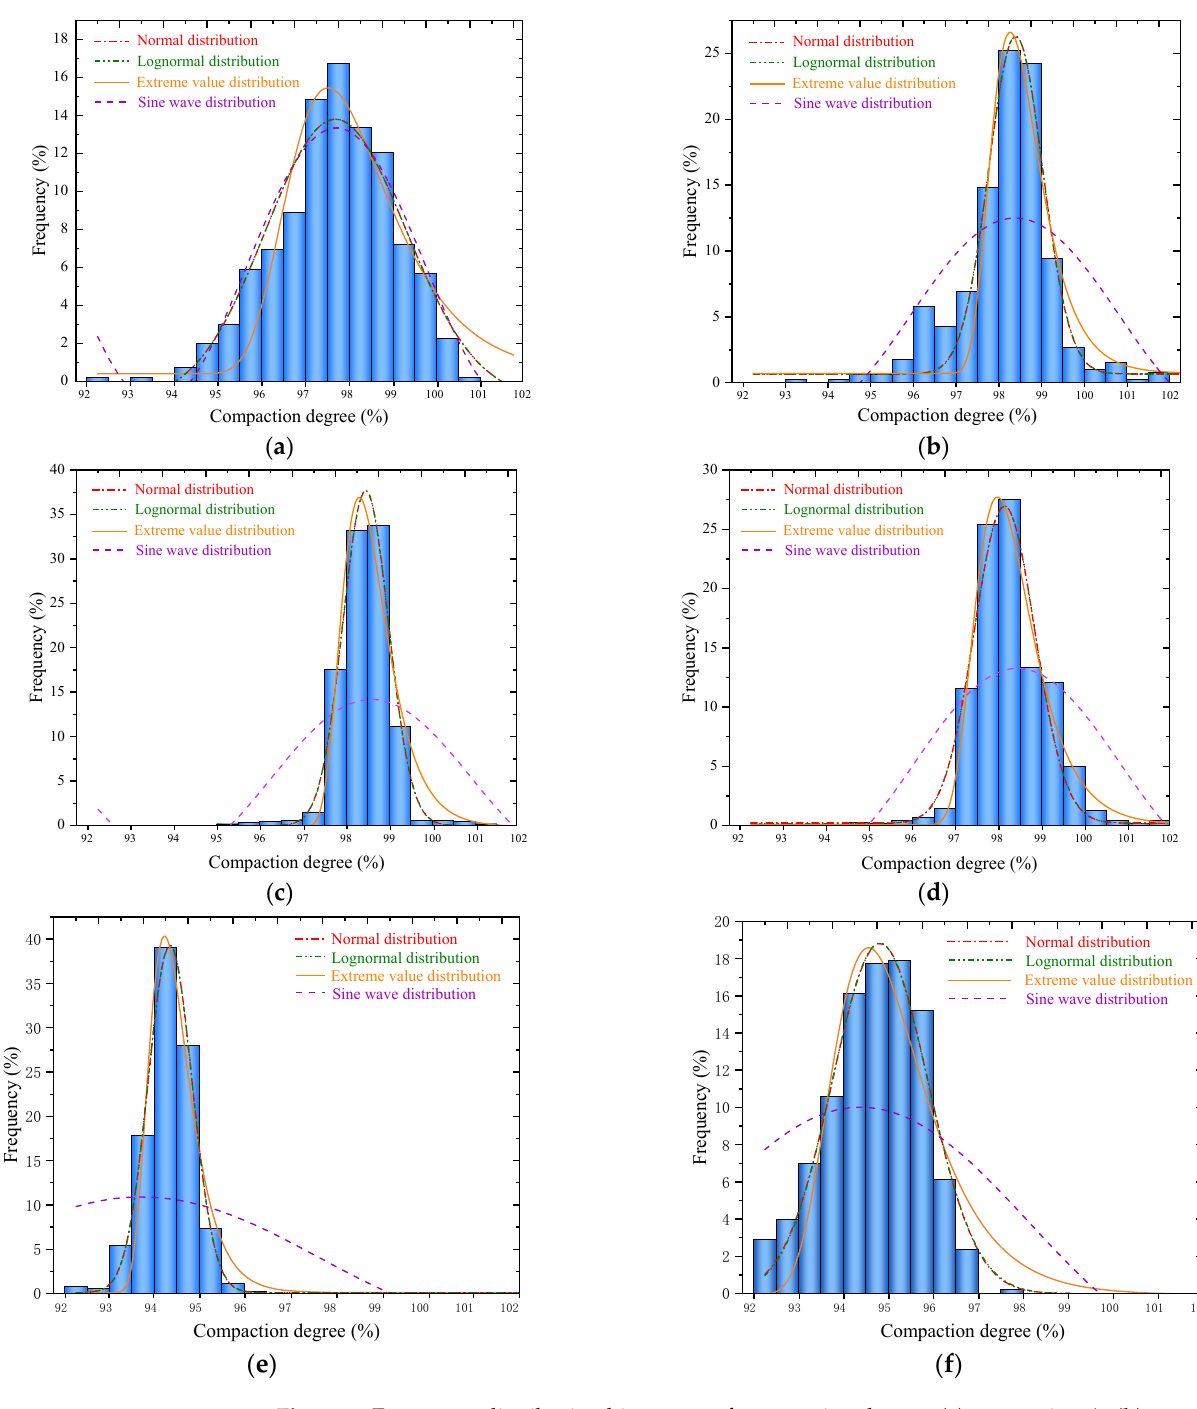
B; ( c ) test section C; ( d ) test section D; ( e ) test section E; ( f ) test section F.